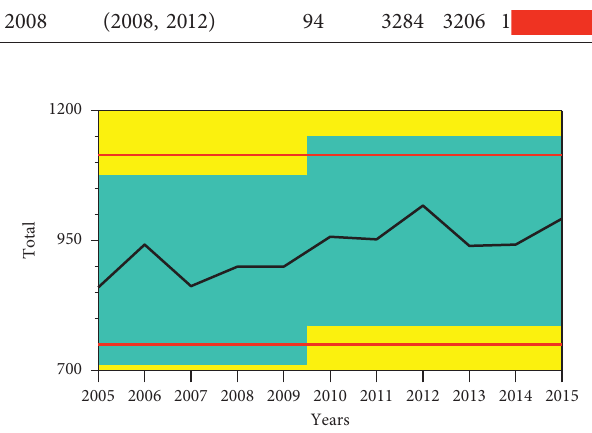
Figure 9: Eastern Cape: CUSUM plot. Table 7: Table of significant changes for murder in Eastern Cape. Years Confidence interval Conf. level From To